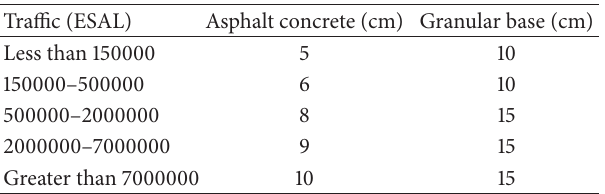
Table 2: Minimum thickness for asphalt concrete and granular base [15].